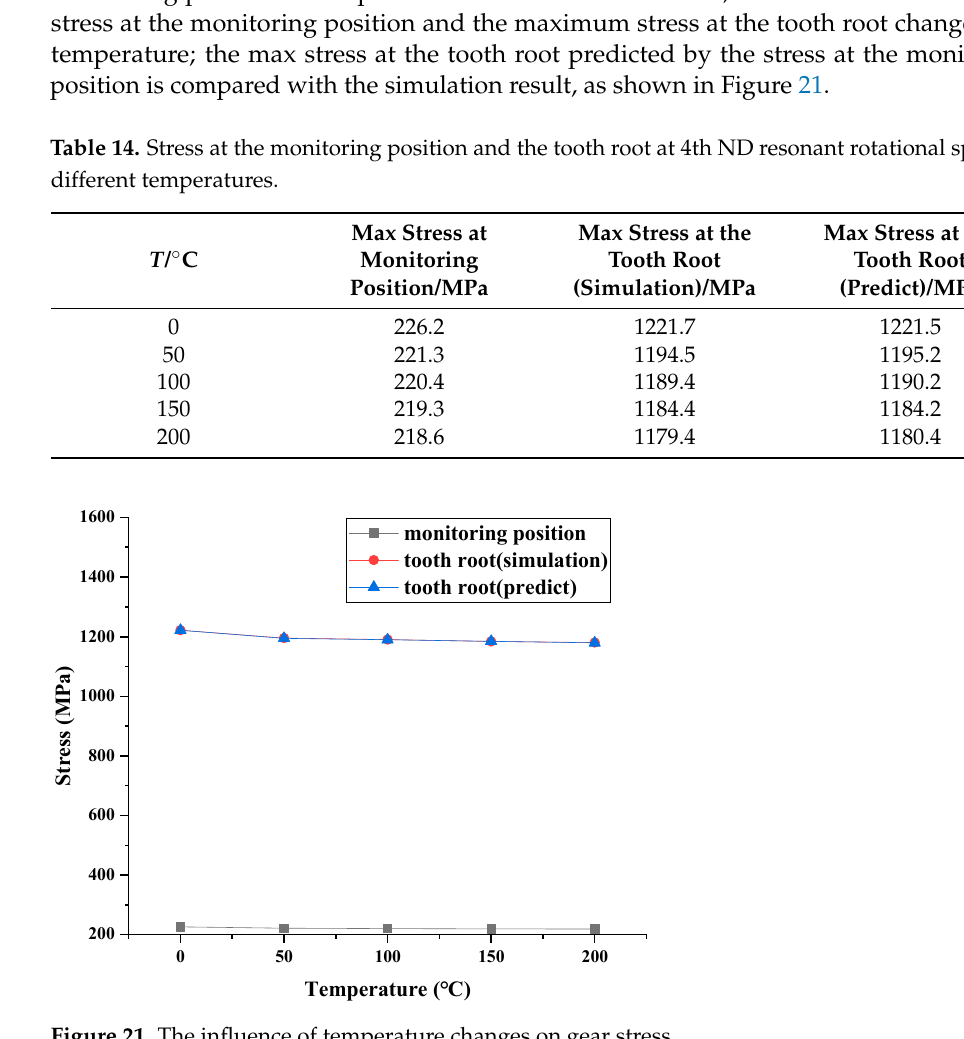
Figure 21. The influence of temperature changes on gear stress.